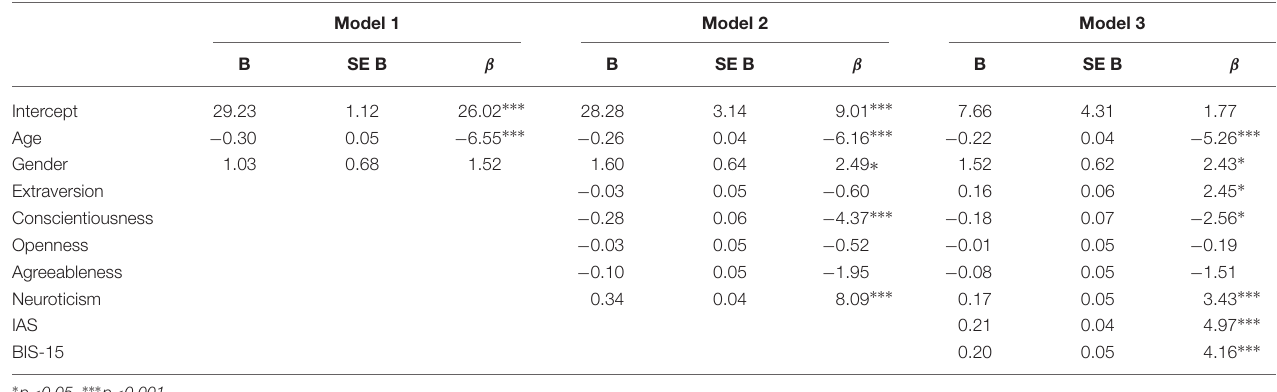
TABLE 6 | Summary of hierarchical regression analysis for variables predicting s-IAT ( N = 733).